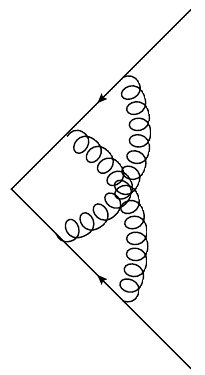
Figure 19 . The (2,2) web: the crossed-gluon diagram denoted by X in the text is the only diagram in the (2,2) web with a non-zero exponentiated colour